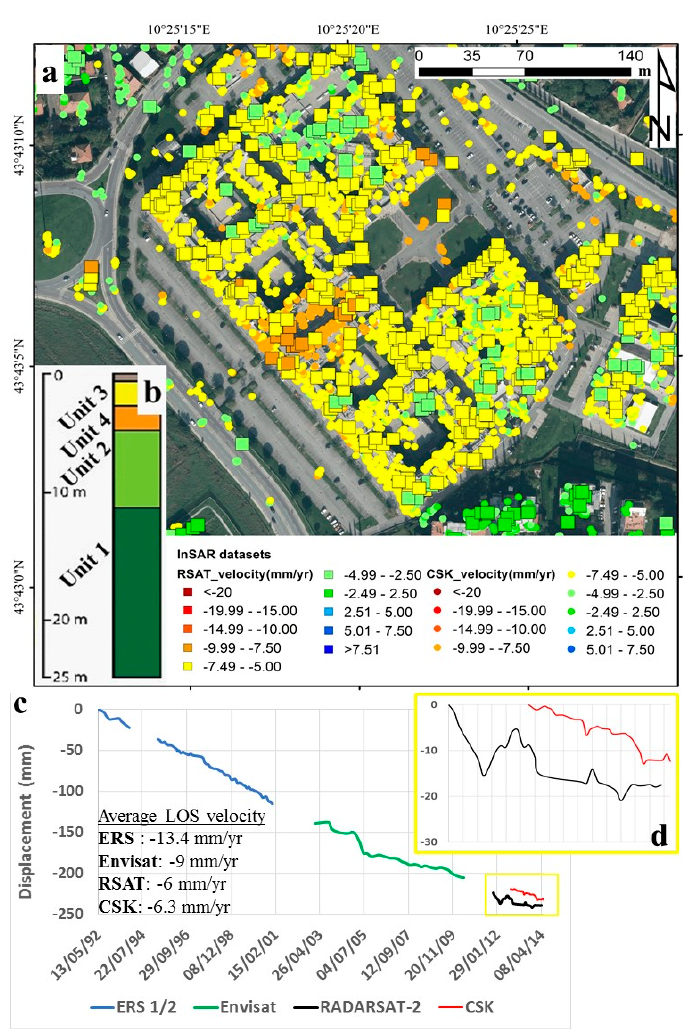
Figure 5. ( a ) LOS displacements affecting the National Research Council (CNR) complex. The displacement map is overlaid on a 2013 digital orthophoto; ( b ) Geological reconstruction of the stratigraphical asset, the classification is the one proposed by Sarti et al. [43]; ( c ) ERS 1/2, Envisat, RADARSAT-2 and COSMO-SkyMed average time series for the analyzed building. The ERS 1/2 and Envisat time series have been modified after Solari et al. [6]. The RADARSAT-2 and COSMO-SkyMed time series are shifted by a constant value for a better visualization; ( d ) RADARSAT-2 and COSMO-SkyMed average time series for the investigated period. The y axis units refer to the displacement in millimeters.